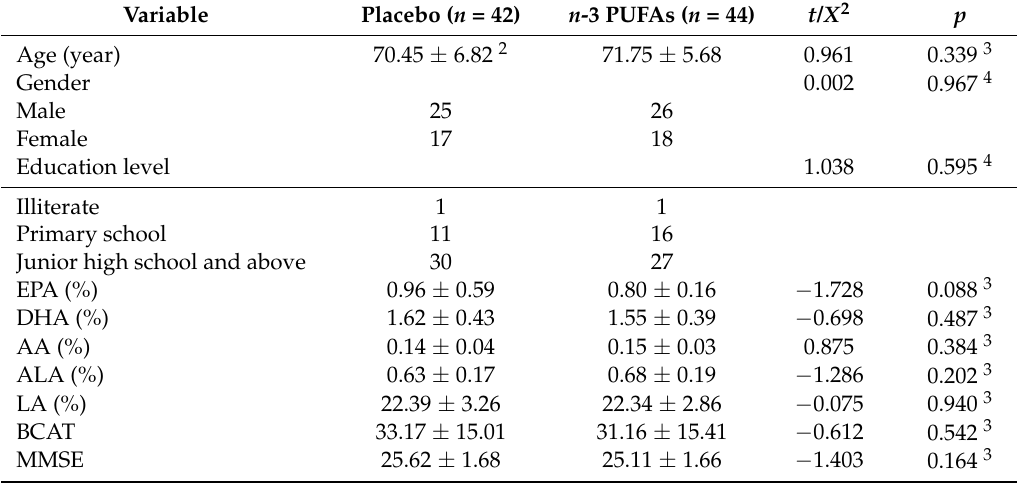
Table 1. Baseline characteristics of subjects 1 .